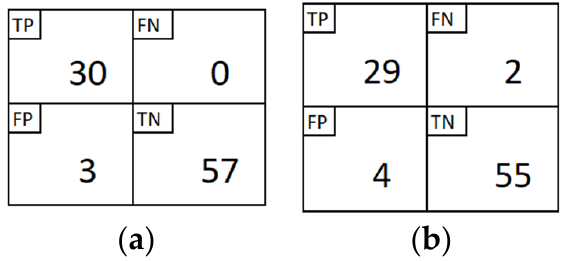
Figure 7. The confusion matrix evaluation of the ANN model is trained with ( a ) backpropagation and ( b ) structural learning with forgetting.